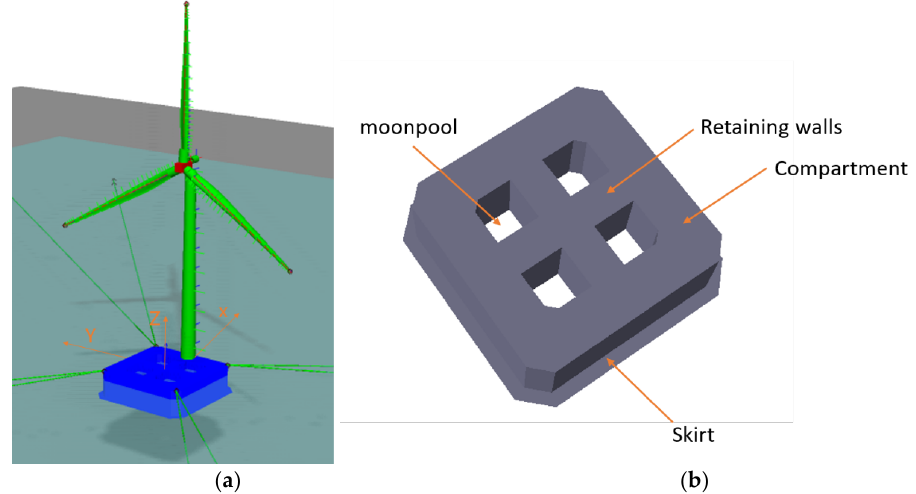
Figure 2. Illustration of the proposed barge-type FOWT: ( a ) sketch of the overall barge-type FOWT with the global coordinate system including wind turbine, barge platform, and mooring system; ( b ) details of the barge platform.